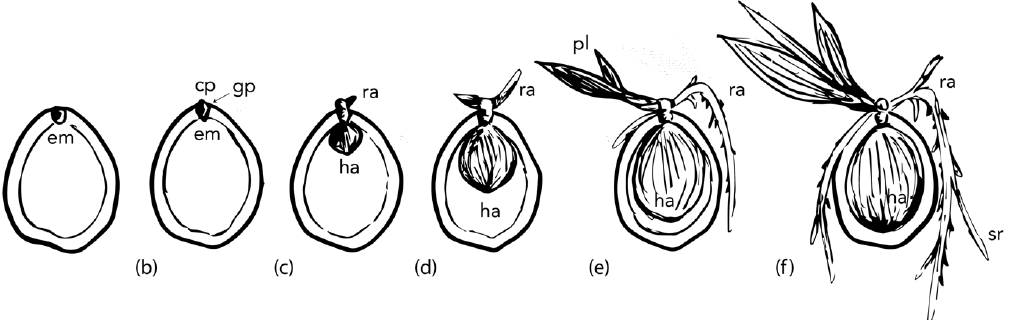
Figure 4. Coconut germination stages: ( a ) Ungerminated coconut fruit. Embryo (em) consists of a short plumular-radicular axis. The plumule consists of a central meristematic zone enclosed by scaly-leaf primordia, which are then surrounded by the cotyledonary petiole. ( b ) In the proximal end of the embryo, the cotyledonary petiole (cp) extends through the germination pore (gp). ( c ) Germinative button formation and radicle emergence (ra) from the cotyledonary petiole. The cotyledonary blade (distal end of the embryo) starts expanding to form a haustorium (ha). ( d ) Radicle elongation, plumule emergence and continuous haustorium growth. ( e ) Secondary roots forming, plumule elongation and first leaves, extensive haustorium growth. ( f ) Secondary root (sr) growth, leaf growth, haustorium completely fills the inner cavity (endosperm).